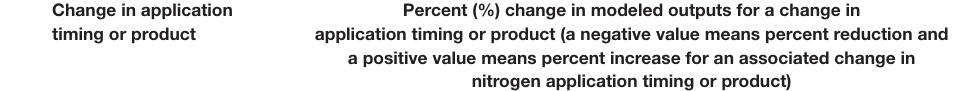
TABLE 2 | Effects of nitrogen fertilizer application timing (fall vs. spring) and products (urea vs. ESN) on modeled annual dryland or rain-fed barley grain yields, modeled annual grain N uptake, and different forms of modeled annual nitrogen losses averaged over the simulation period (2011–2015) for all the townships across mid-slope landforms of Alberta under simulated barley